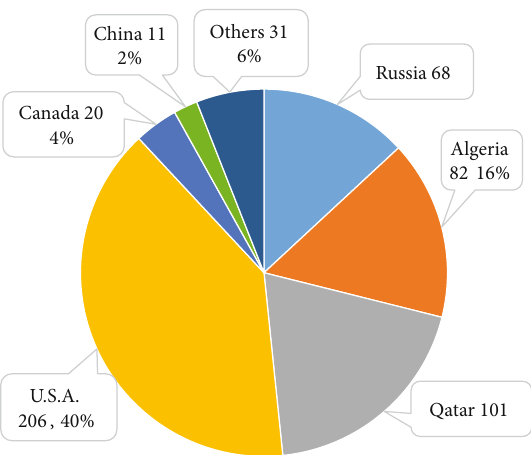
Figure 3: World helium production [6,